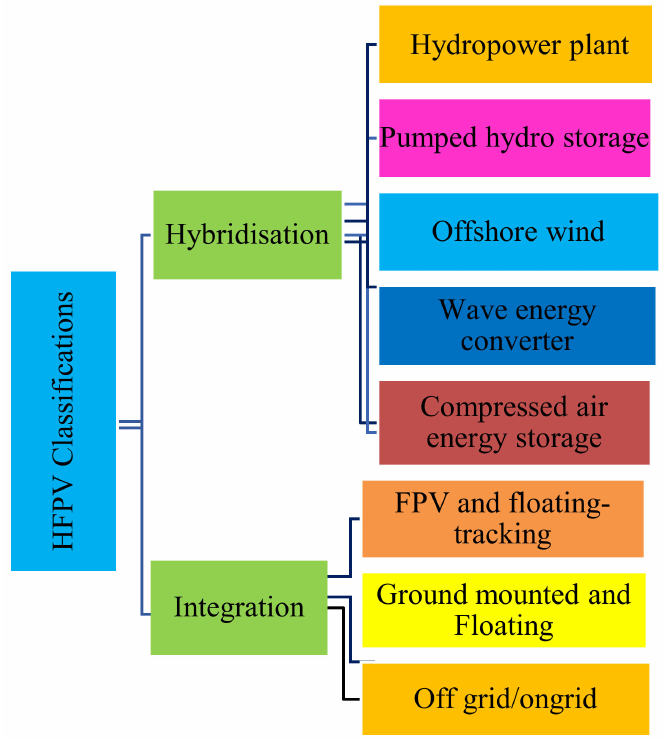
Figure 3. Classification of HFPV (Modified from